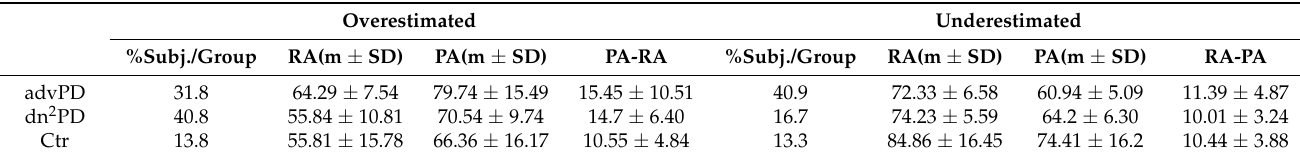
Table 5. Difference between the chronological age and the predicted age (years) for each study group. Overestimated are the individuals that are predicted at least 6 years older than their actual chronological age; underestimated are individuals that are predicted at least 6 years younger than their actual chronological age. Percentage reported refers to the total of misclassified individuals per group.